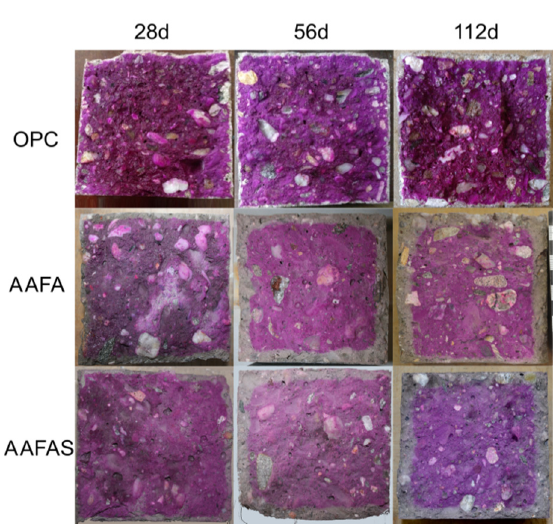
Figure 1. Fractured surface of concrete cubes (100 mm³) after 28, 56, and 112 days in 20 °C, 65% rH, 0.04 Vol.-% CO 2.